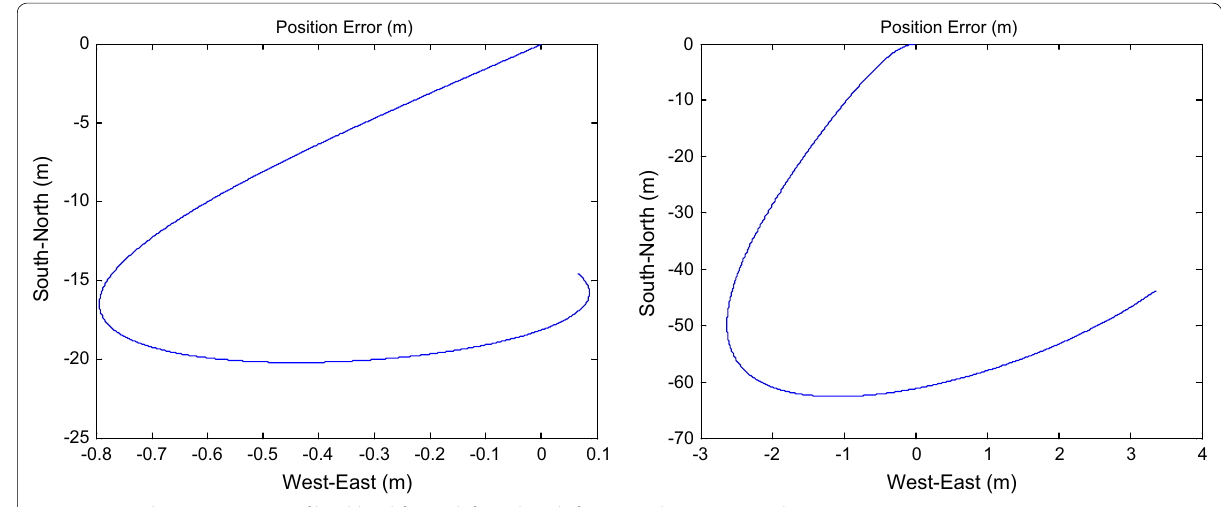
Fig. 3 Non-polar position errors of local-level-frame (left) and Earth-frame mechanizations (right)